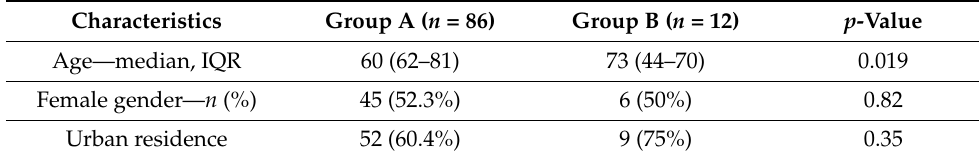
Table 1. Demographic characteristics of the